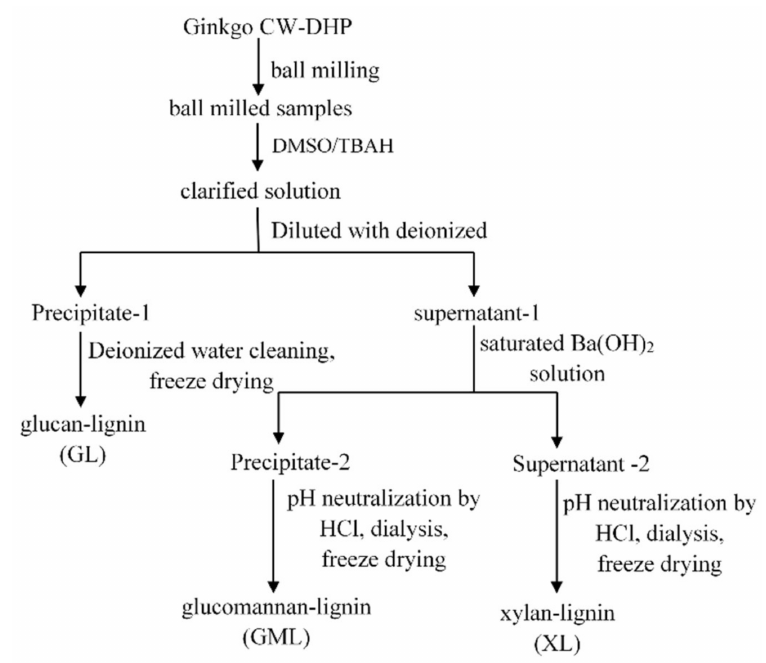
Figure 14. Fractionation of LCC from Ginkgo